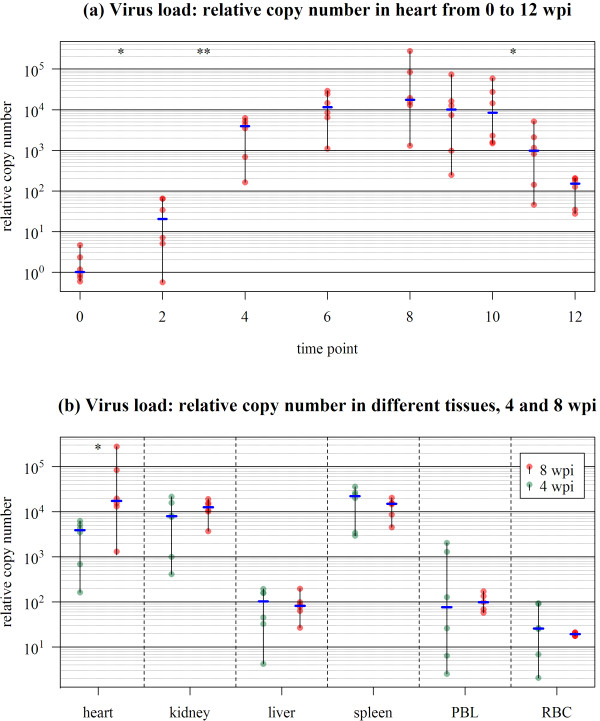
Assessment of viral load by qPCR. (a) Time course study in heart tissue: PMCV levels are shown as relative copy numbers for six individuals per time point. Copy numbers are relative to the median of the 0 wpi values which was set to 1. The black lines show the variance and blue bars represent the median. (b) PMCV levels in different tissues at 4 and 8 wpi. Relative copy numbers are shown as green dots (4 wpi) or red dots (8 wpi). Numbers are relative to median of 0 wpi values set to 1 (a). Levels of significant differences (t-test) were calculated for log-transformed values.